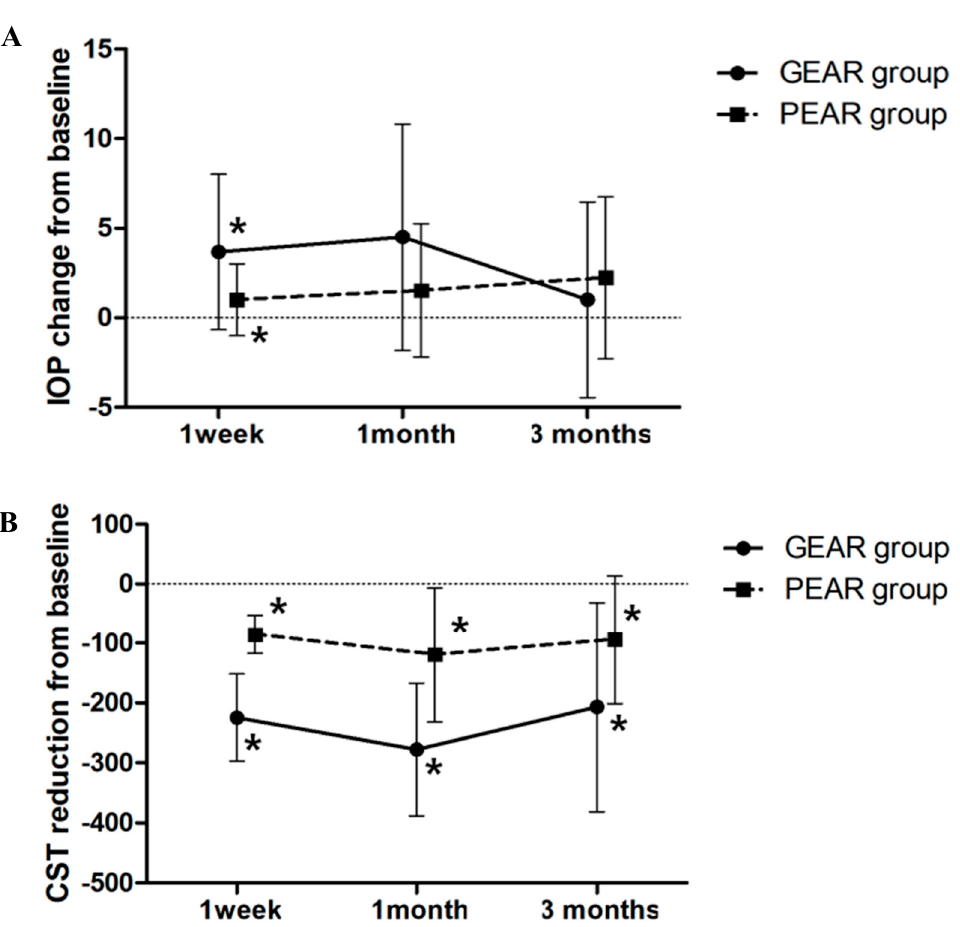
Figure 2. Graph illustrating changes in mean intraocular pressure (IOP) elevation and mean central subfield thickness (CST) reduction after intravitreal dexamethasone (DEX) implantation between good early anatomic responder (GEAR) and poor early anatomic responder (PEAR) groups. ( A ) Mean IOP change. ( B ) Mean CST reduction. Asterisk (*) means significant di ff erence between the groups. Representative cases from each of the two groups are shown in Figure 3. The first case (left column) was a 58-year-old female with severe NPDR, and the second case (right column) was a 63-year-old female with PDR. Each eye received two rounds of intravitreal bevacizumab injection and panretinal photocoagulation (PRP) 3 months before intravitreal DEX implantation. The Snellen best-corrected visual acuity (BCVA) was 0.4, the central subfield thickness (CST) was 515 µ m, and the intraocular pressure (IOP) was 14 mmHg at baseline in the eye of the GEAR group. At 1 week after intravitreal DEX implantation, the CST decreased to 309 µ m and the IOP increased to 24 mmHg, and the patient was treated with topical anti-glaucoma agents. In the case of the PEAR group, the Snellen BCVA was 0.3, the CST was 575 µ m and the IOP was 15 mmHg at baseline. At 1 week after intravitreal DEX implantation, the CST decreased to 439 µ m and the IOP increased to 17 mmHg. At 3 months, the CST increased to 487 µ m, but the IOP was stable at 14 mm.